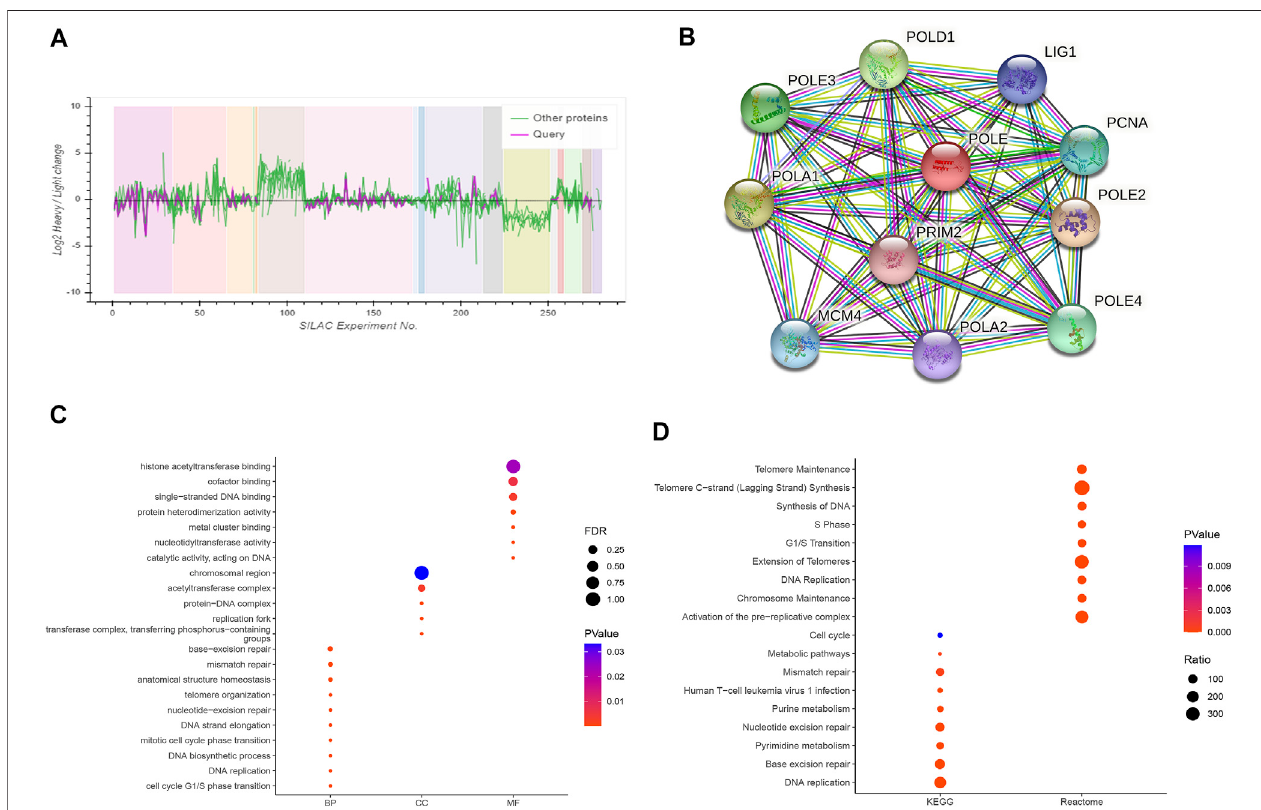
FIGURE 7 | Construction of a protein – protein interaction (PPI) network and functional enrichment analysis. (A) Analysis of 11 proteins coordinately regulated with polymerase epsilon (POLE). (B) The PPI comprised 11 hub proteins, as follows: POLE, POLE2, POLE3, POLE4, PCNA, LIG1, POLD1, POLA1, POLA2, MCM4, and PRIM2. (C, D) Gene Ontology (GO) functional annotation, including biological process, cellular components, and molecular function, and enrichment analyses of Kyoto Encyclopedia of Genes and Genomes (KEGG) and Reactome pathways were used to characterize the hub proteins. We found critical factors such as DNA replicationandDNAbiosyntheticprocessinbiologicalprocess(BP),replicationforkandprotein – DNAcomplexincellularcomponent(CC),nucleotidyltransferaseactivity and metal cluster binding in molecular function (MF), base excision repair and nucleotide excision repair in KEGG, and extension of telomeres in Reactome.